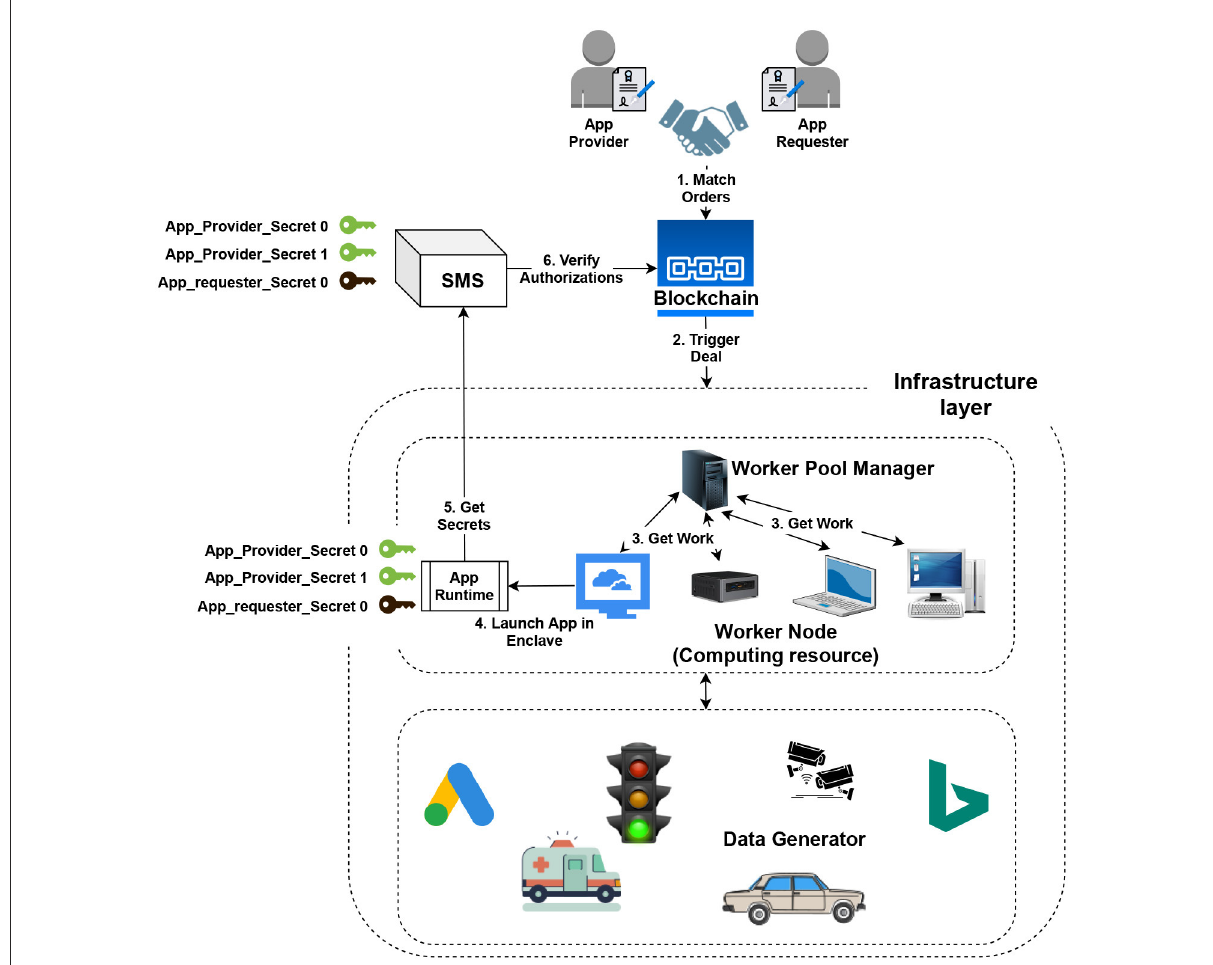
FIGURE5 Work-diagram: For deal-based resource selection and secure App execution in trusted environment.